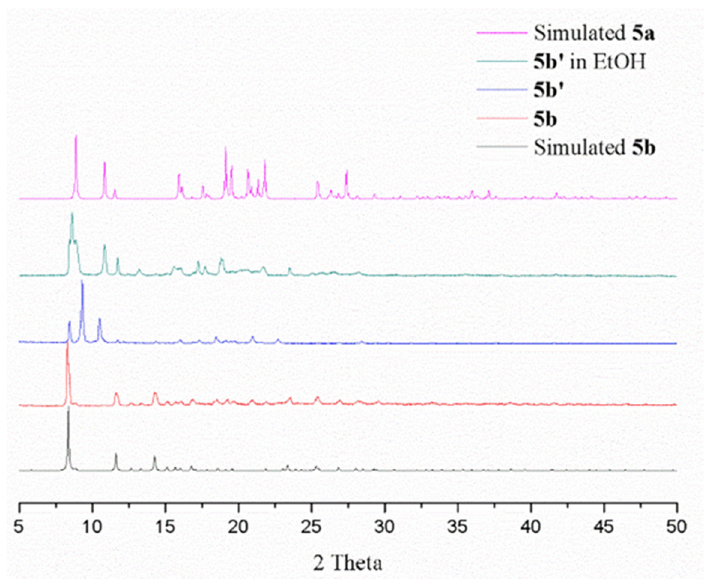
Figure 8. The PXRD patterns for complexes 5a , 5b ·H 2 O , 5b’ and 5b’ immersed in ethanol.